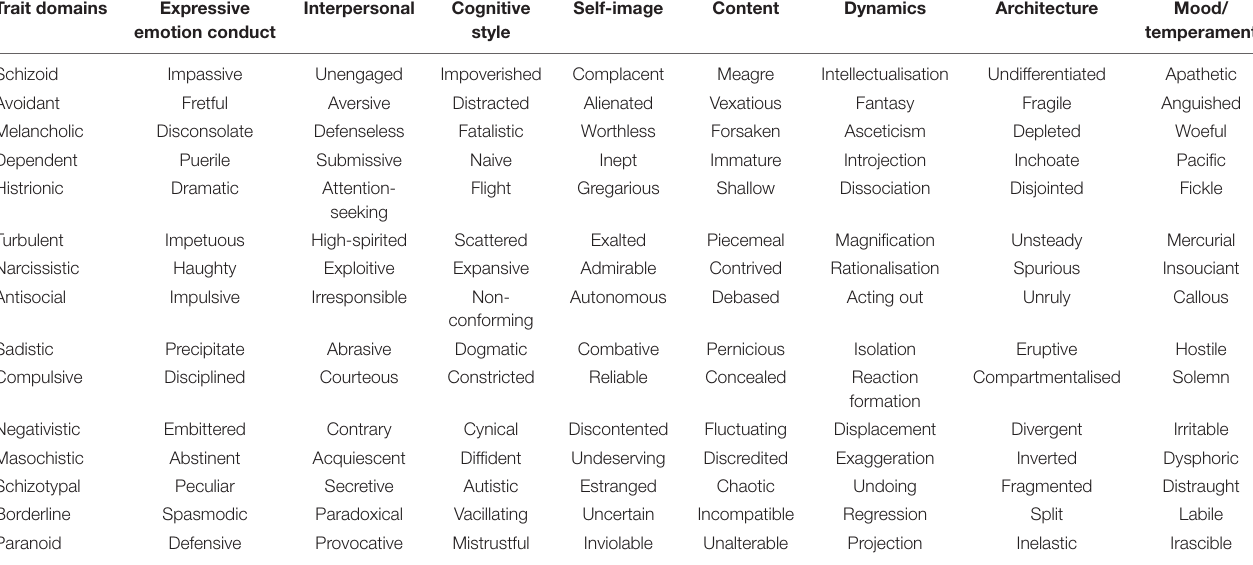
TABLE 2 | Expressions of personality spectra across trait